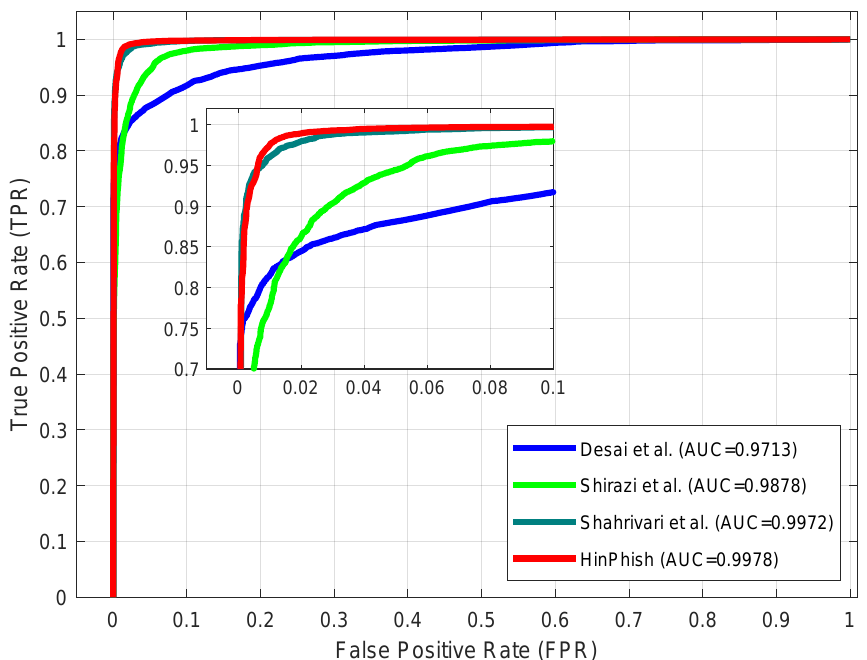
Figure 9. ROCs of Machine Learning-based Methods and